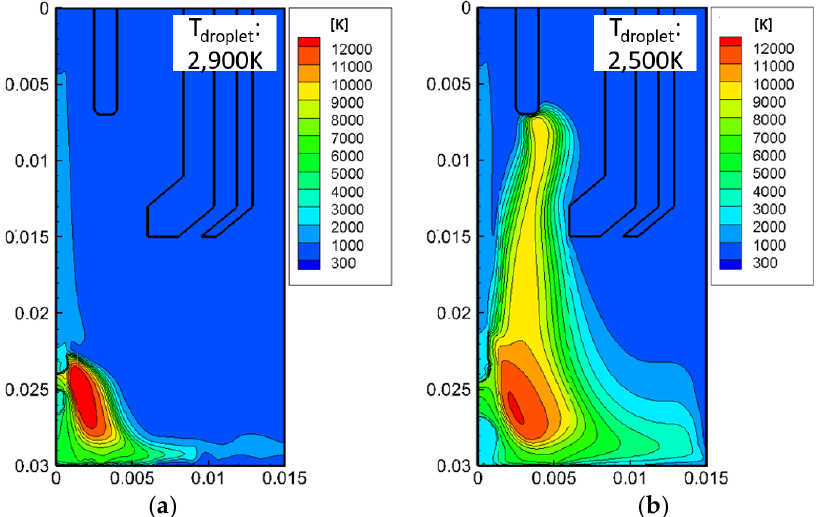
Figure 3. Temperature distributions in ( a ) conventional MIG welding and ( b ) plasma – MIG welding.